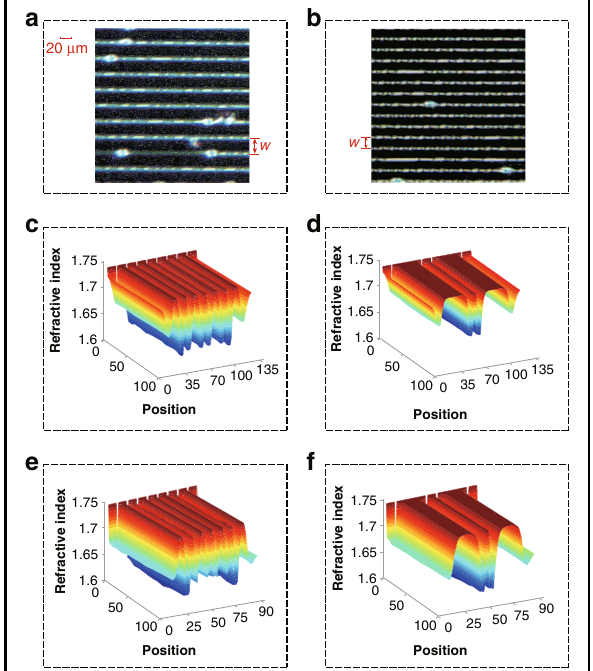
Fig. 6 Properties of the tunable liquid crystal grating. a , b Tunable liquid crystal grating with w of 30 μ m and 20 μ m, respectively. c, d Refractive index distribution of the tunable liquid crystal grating with w of 30 μ m in the small and large periodic orders, respectively. e, f Refractive index distribution of the tunable liquid crystal grating with w of 20 μ m in the small and large periodic orders,